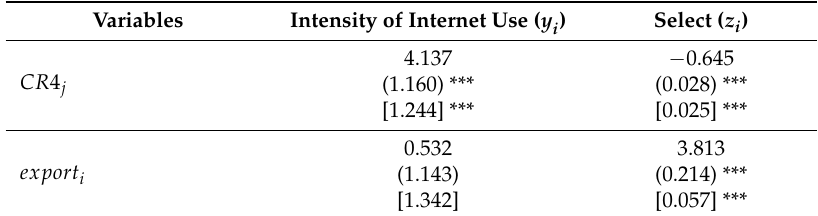
Table 6. Selection corrected internet intensity (with top four-firms’ concentration ratio (CR4)) for all